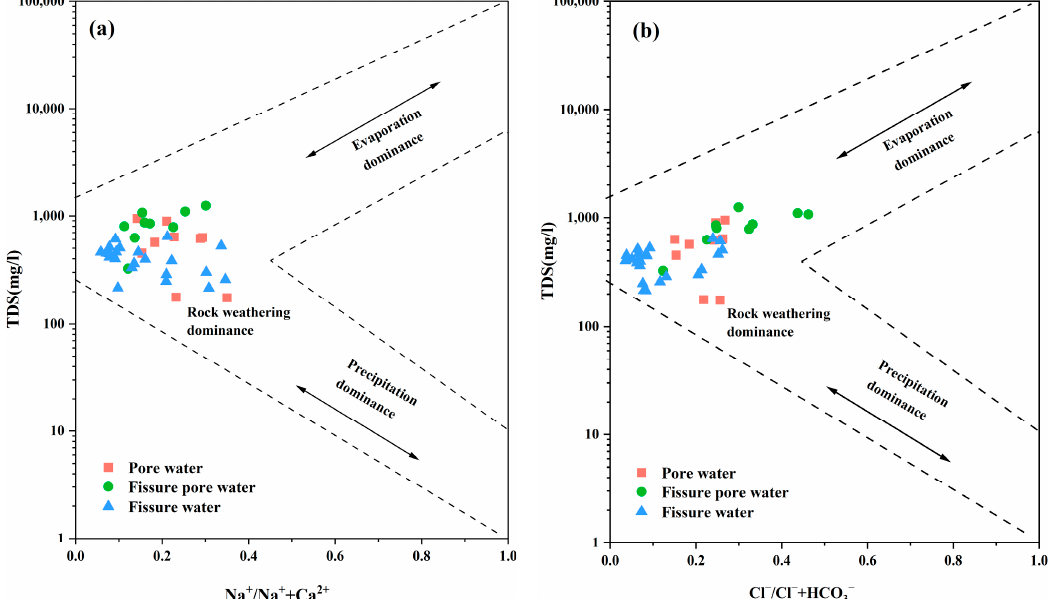
Figure 7. Gibbs plots of factors influencing the chemical characterization of groundwater in the Wulian. (TDS vs. Na + /(Na + +Ca 2+ ) ( a ) TDS vs. Cl − /(Cl − +HCO 3 − ) ( b )). Wulian. (TDS vs. Na + /(Na + + Ca 2+ ) ( a ) TDS vs. Cl − /(Cl − + HCO